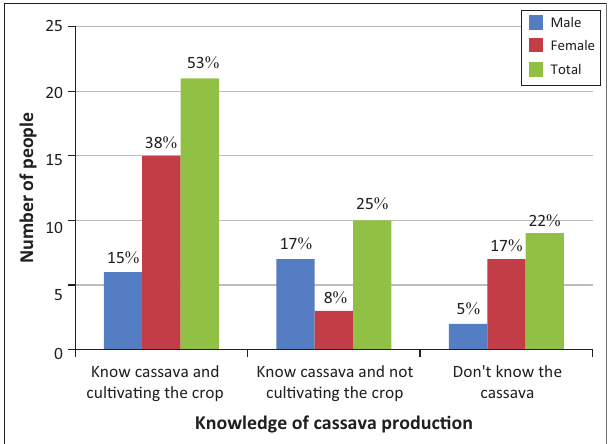
FIGURE 9: Cassava production in Chilonga